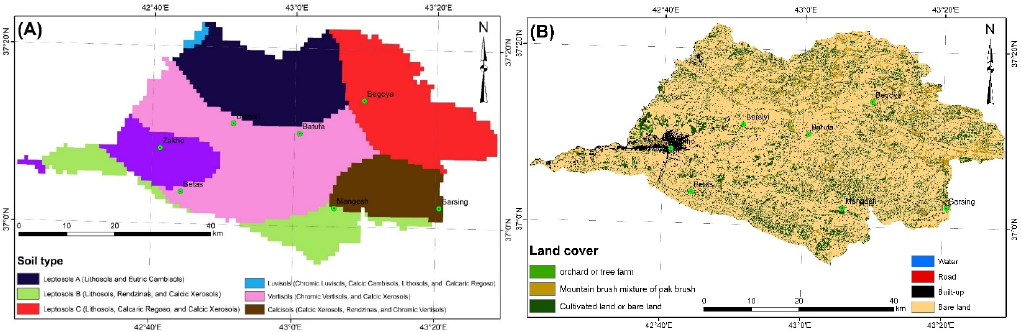
Figure 6. Maps are showing: ( A ) soil types [66], and ( B ) land cover (LC) units.